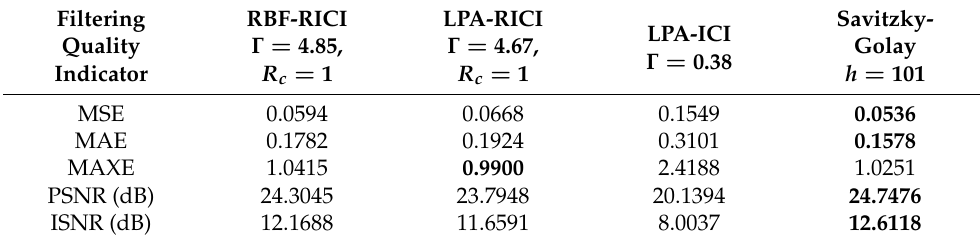
Table 24. HeaviSine signal (SNR = 10 dB)—Filtering results.